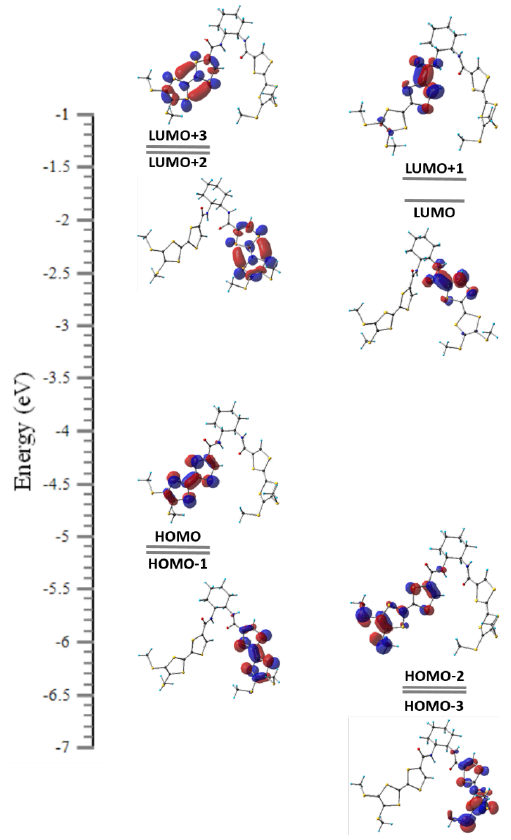
Figure 12. Most relevant frontier MOs involved in the monoelectronic excitations computed for compound ( R , R )- 1 at the B3LYP/Def2-SVPD level of theory. Brief description of the MOs: HOMO-3 to HOMO: π orbital on the two TTF units; LUMO and LUMO+1: π* orbitals on the two different arms of compound ( R , R )- 1 ; LUMO+2 and LUMO+3: σ* orbital on the TTF units.